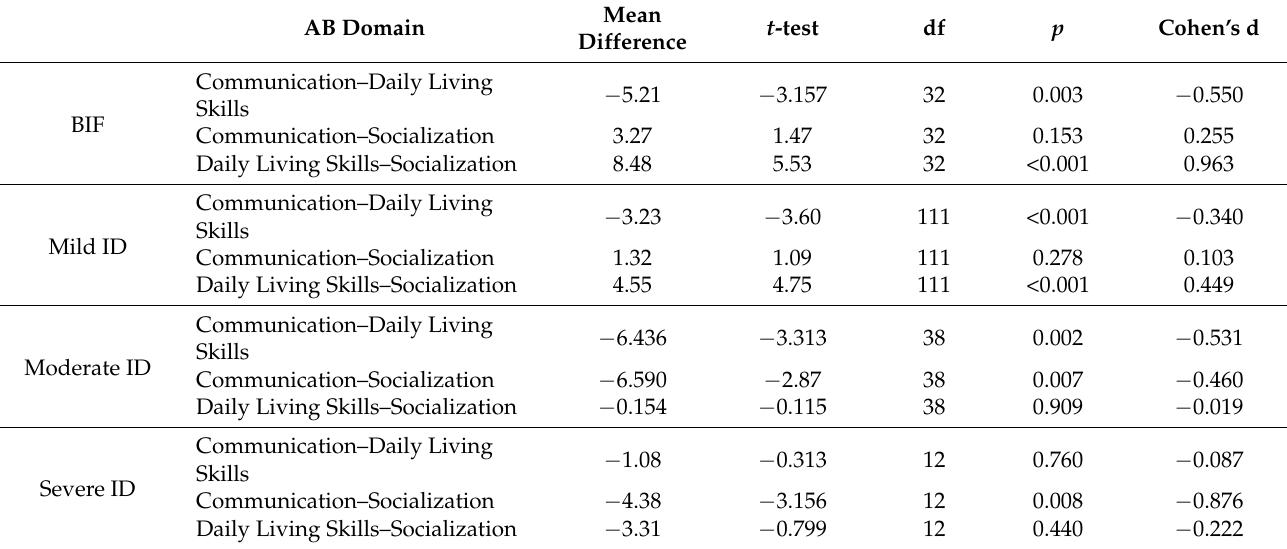
Table A5. Mean differences of AB domains in each level of